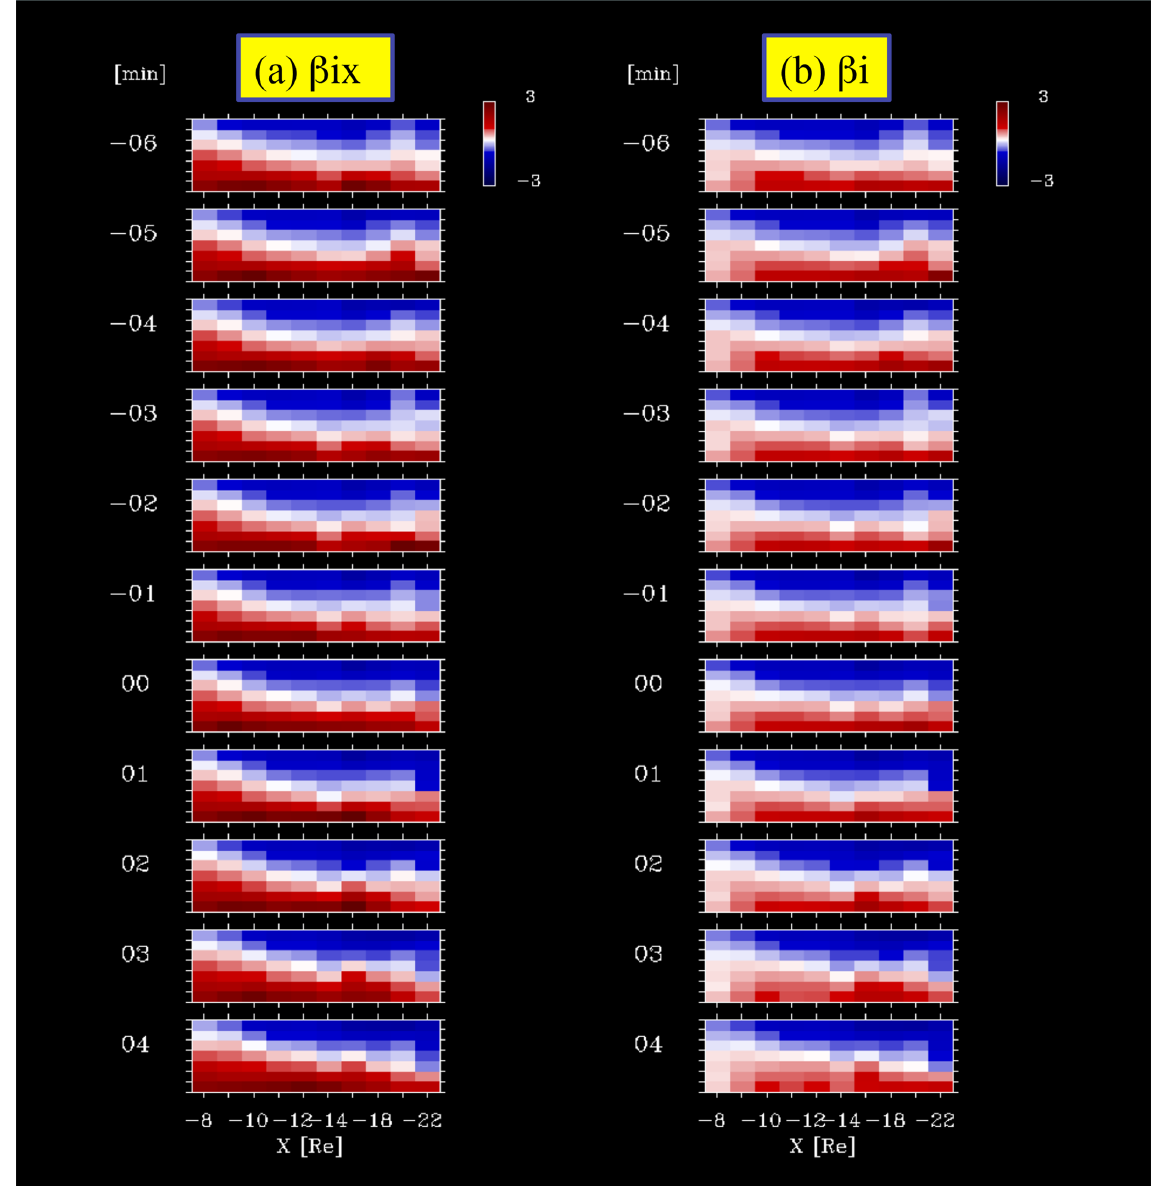
Fig. 2. Temporal evolution of (a) β i